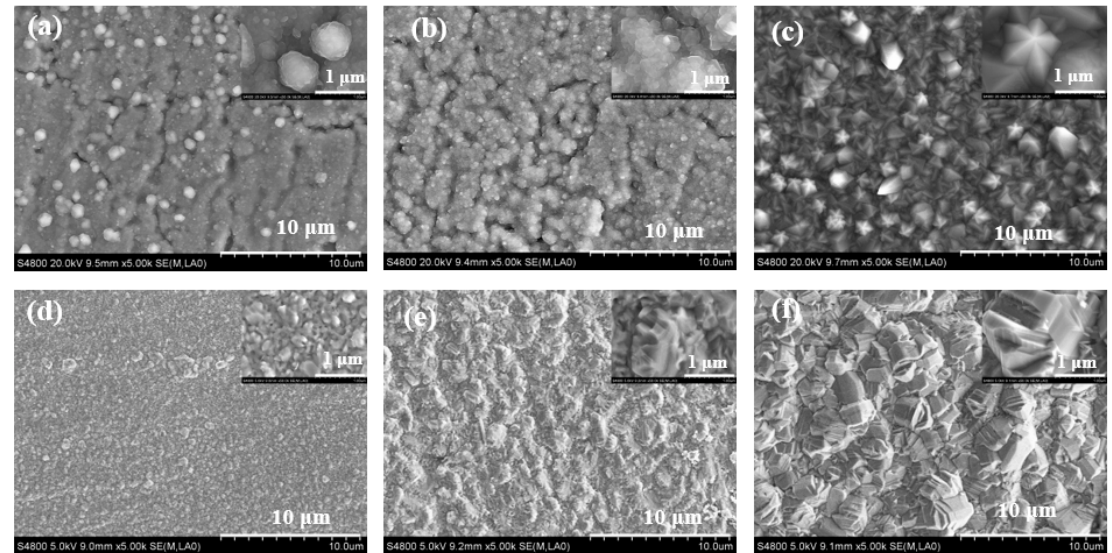
Figure 1. Scanning electron microscopy (SEM) micrographs of TiN at 850 ◦ C with di ff erent deposition time: ( a ) 5 min, ( b ) 30 min, and ( c ) 90 min; TiO 2 at 800 ◦ C with di ff erent deposition time: ( d ) 5 min, ( e ) 30 min, and ( f ) 90 min.